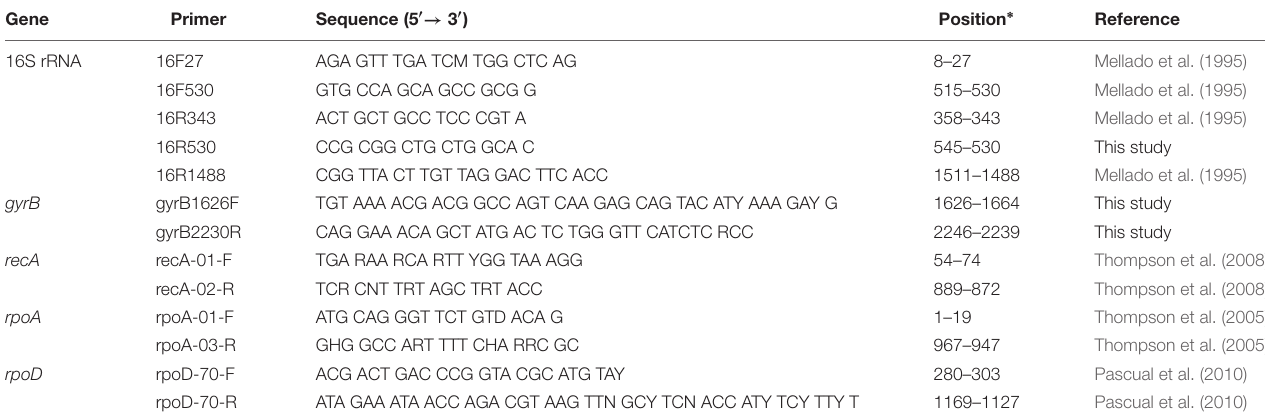
TABLE 1 | Oligonucleotide primers used for PCR amplification and